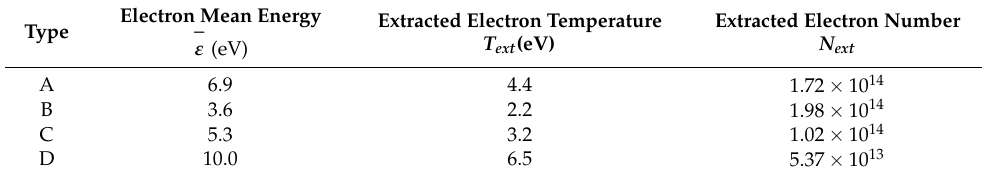
Figure 7. Diagram of the proportion of electron energy at the extraction surface under the four types of reaction types when T = 9 ∼ 15 µ s with the emission electron beam at a temperature of 10 eV. Table 3. The related parameters of extracted electrons during T = 9 ∼ 15 µ